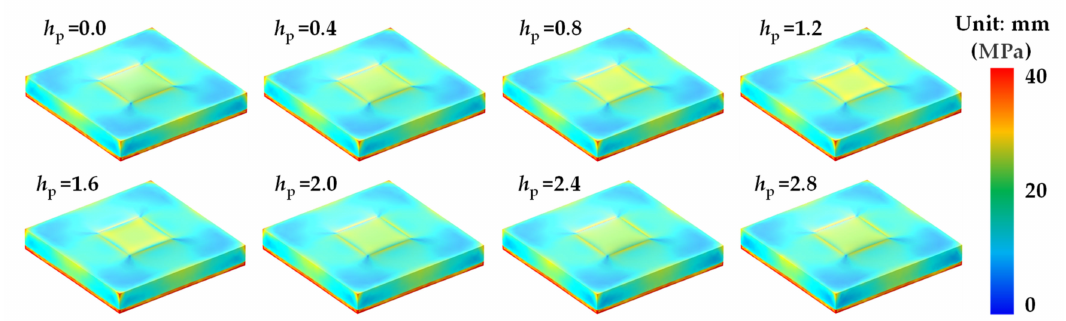
Figure 10. Surface stress of the MEMS pressure chip at different h p at 150 ◦ C.